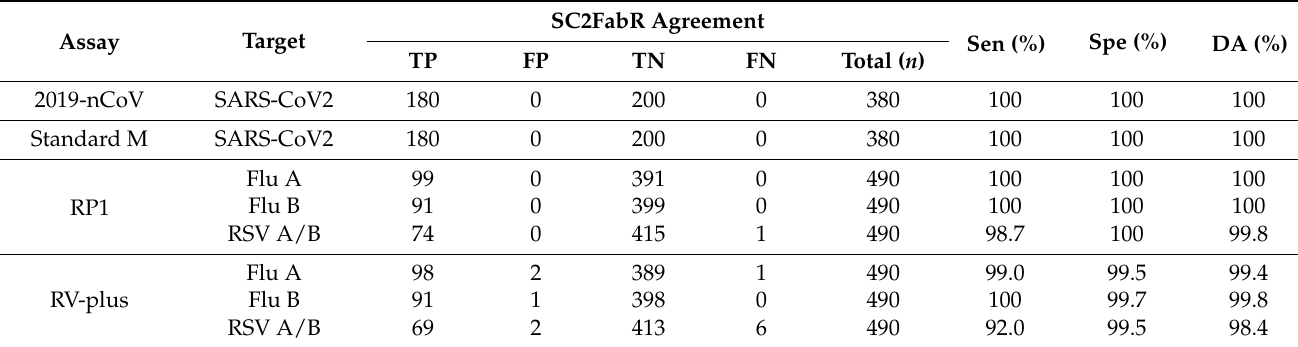
Table 2. Comparison of the clinical performance between different assay systems for the detection of SARS-CoV2 and RV in NPS samples.